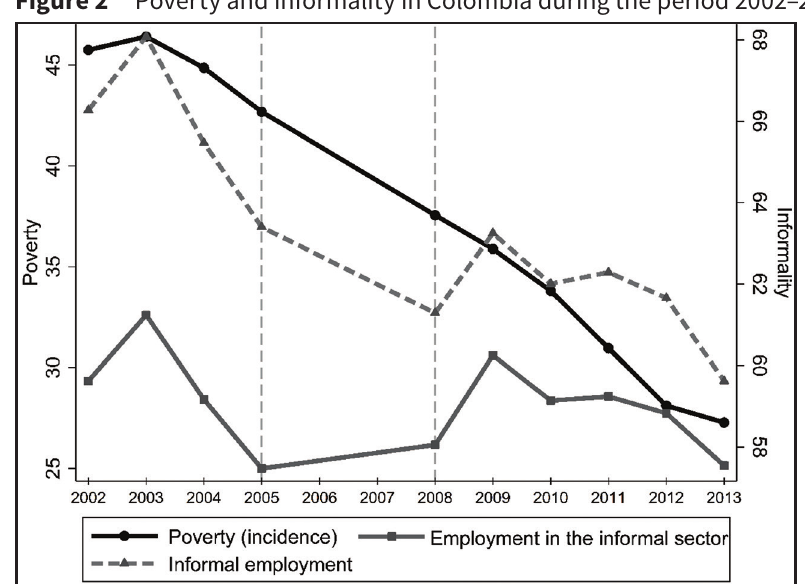
Figure 2 Poverty and informality in Colombia during the period 2002–2013.